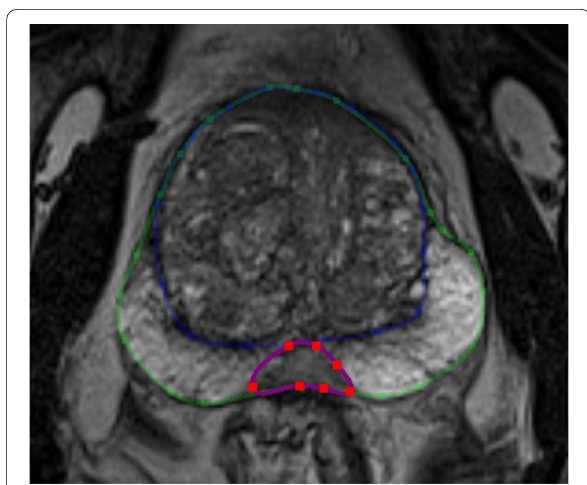
Fig. 1 Example of anatomic zonal segmentation. The central zone (purple) is included in PZ (green contour minus blue contour), and not in TZ (blue) on this